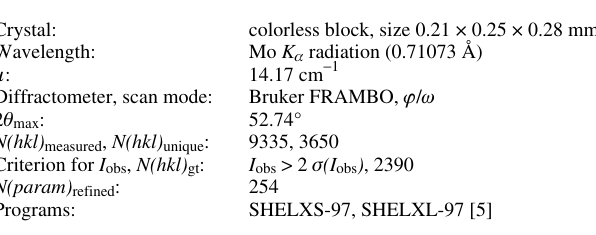
Table 1. Data collection and handling.